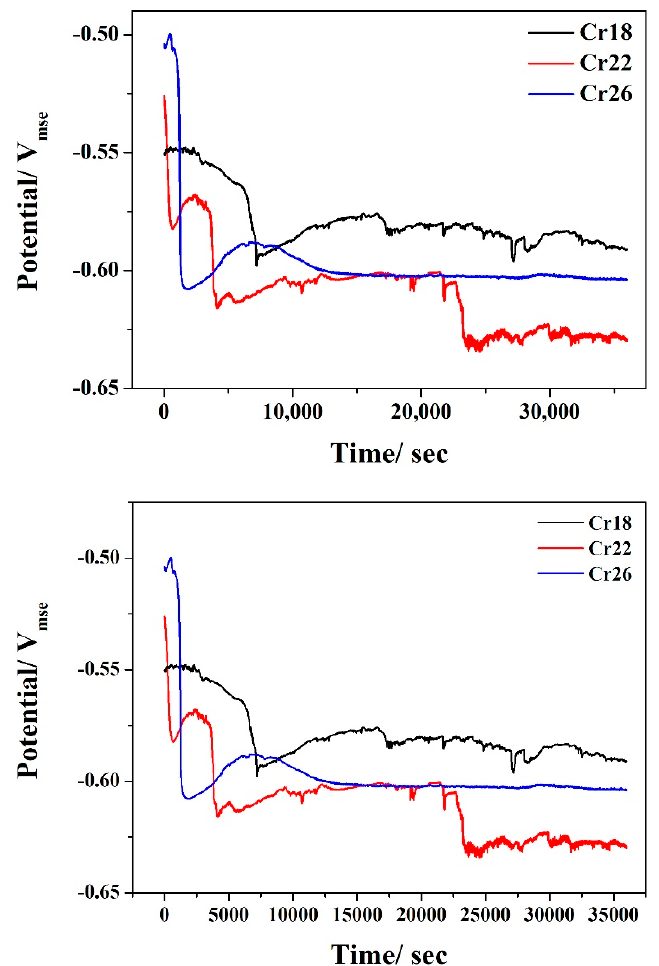
Figure 6. Open circuit potential of Ni-Cr-Mo alloy coatings in 50 wt.% H 2 SO 4 solution at 60 °C.